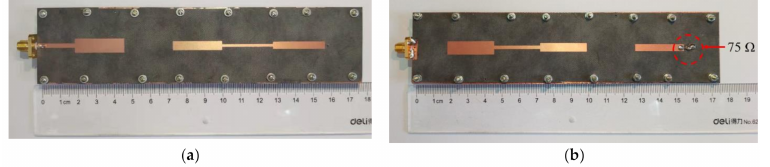
Figure 12. Photographs of the fabricated transformer. ( a ) Front-side view; ( b ) back-side view.